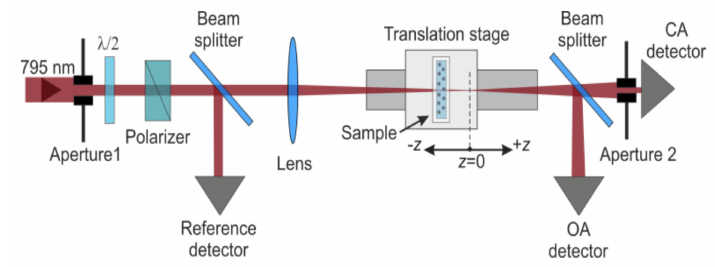
Figure 4. Sketch of the z-scan experimental